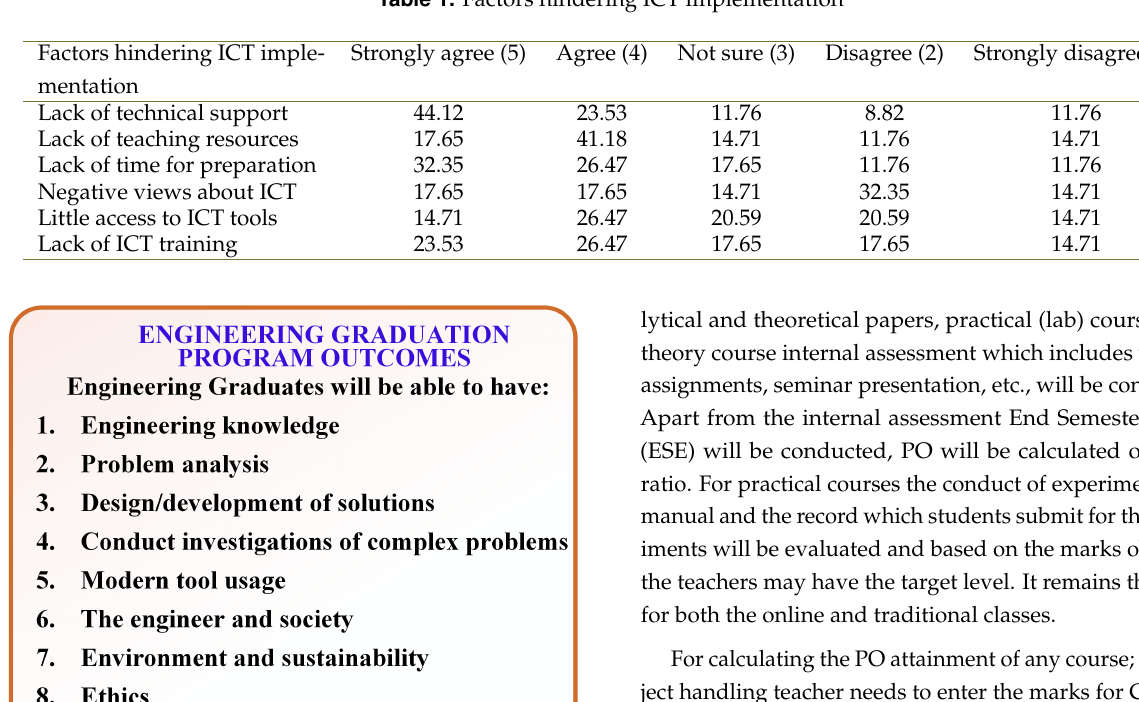
Table 1. Factors hindering ICT implementation